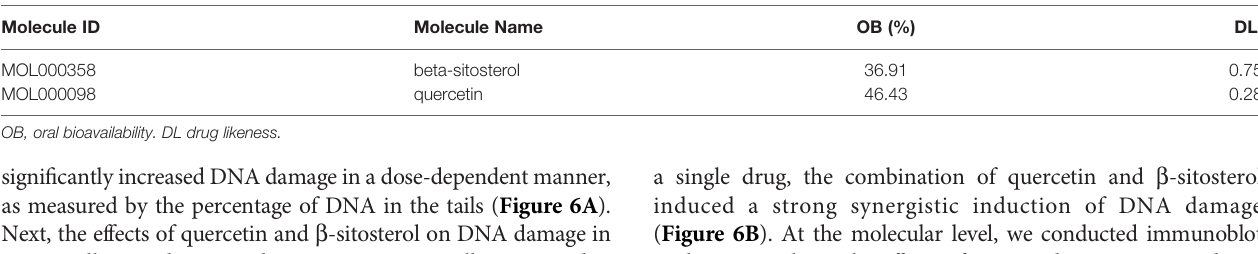
TABLE 1 | Bioactive Compounds of